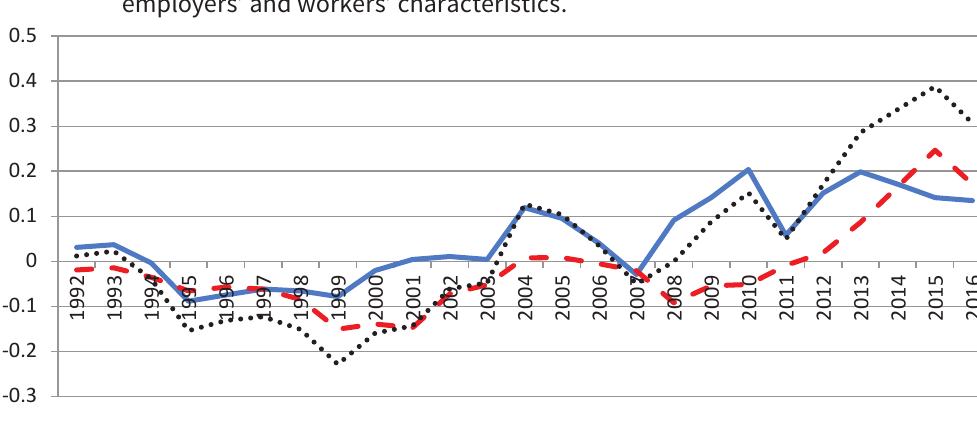
% due to employer composition % due to composition Source: own calculations on INPS data. Note: this figure plots the results on composition effects obtained from the BO decomposition (this is therefore the part of aggregate wage